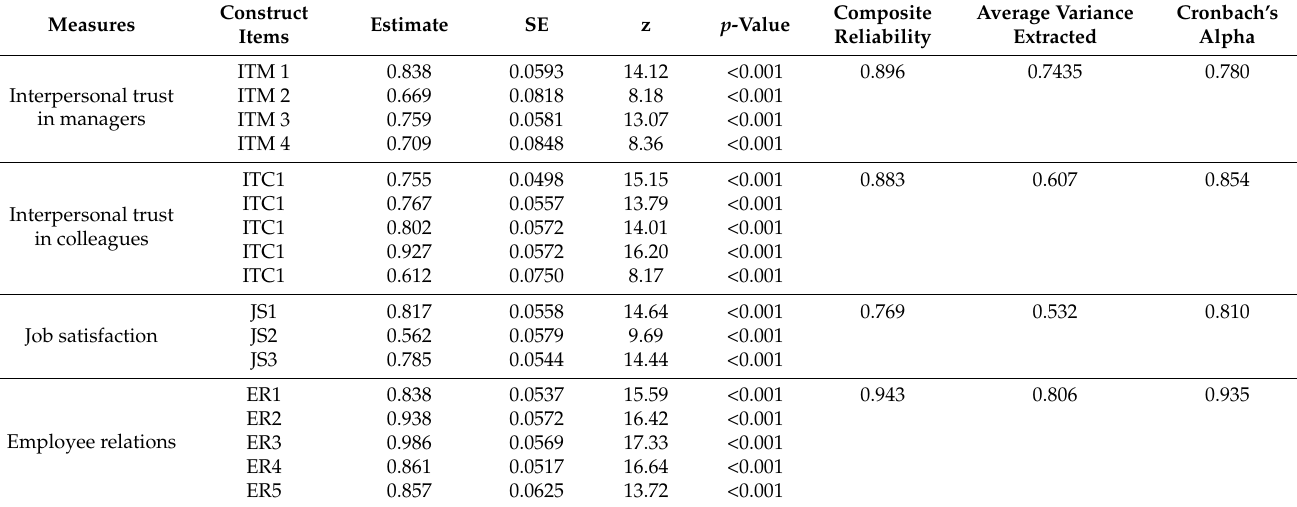
Table 3. Reliability analysis of